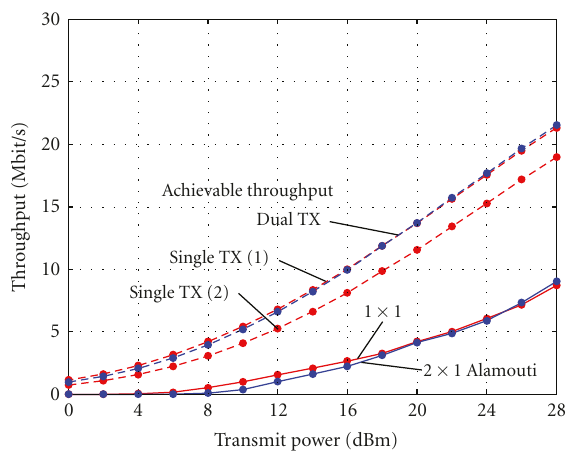
Figure 5: Scenario 1, measured (solid) and achievable (dashed) data throughput in the NLOS outdoor-to-indoor scenario using one receive antenna. The largest transmit power corresponds to a receive SNR of about 22dB.